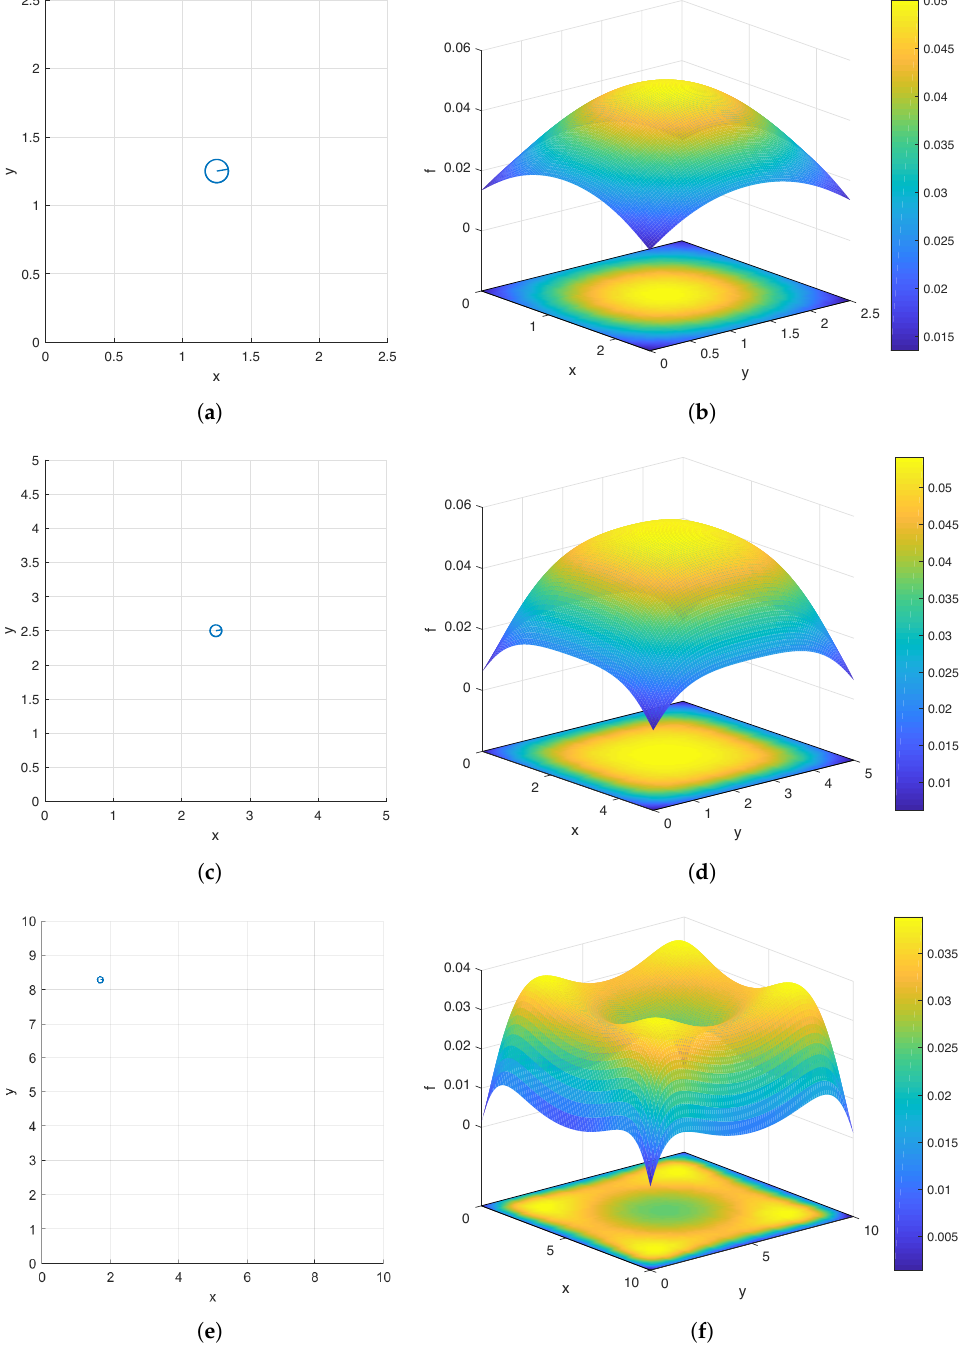
Figure 3. The top views of the optimal carpets found by the hybrid method ( a , c , e ) and the surface and contour plots of f ( θ ) ( b , d , f ) in the case of a single helix. The three rows correspond to three sizes of the flow meter (7): W = 2.5 ( a , b ), 5 ( c , d ), and 10 ( e , f ). To further investigate why the optimal location of the helix is near the corners instead of the center of the domain when the width of the flow meter is 10, in Figure 4, we draw the contour plots of the instantaneous z -direction fluid velocity on the flow meter